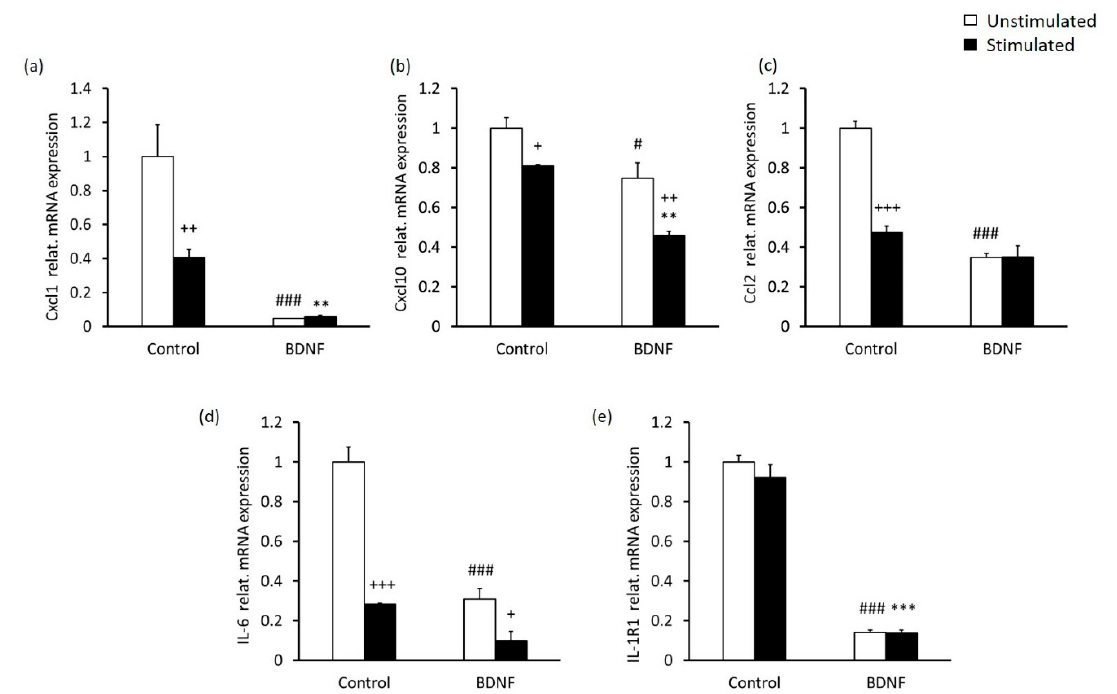
Figure 5. Alterations in the gene expression of chemokines and pro-inflammatory cytokines in MCs after stimulation with BDNF and high contrast. The mRNA levels of chemokines ( a ) Cxcl1 ( b ) Cxcl10 ( c ) Ccl2, ( d ) pro-inflammatory cytokine IL-6 and ( e ) IL-1 receptor type 1 in untreated MCs and MCs treated with 10 nM BDNF and/or high-contrast stimulation. The data are presented as the fold change compared with control (the group without high-contrast stimulation in the absence of BDNF). Differences between the high-contrast stimulated and unstimulated groups: + p < 0.05, +++ p < 0.001. Differences between the high-contrast-stimulated group treated with BDNF and the high-contrast-stimulated group without BDNF treatment: ** p < 0.01, *** p < 0.001. Differences between the unstimulated group treated with BDNF and the unstimulated group without BDNF treatment: # p < 0.05, ### p < 0.001 (two-way ANOVA followed by Tukey’s post-hoc test).